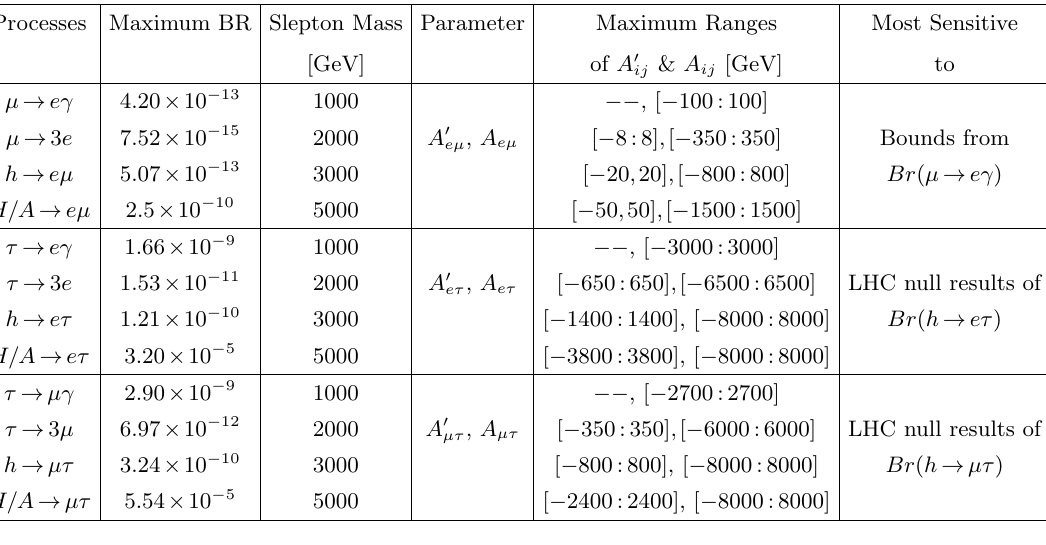
Table 4. Allowed ranges of holomorphic and non-holomorphic trilinear couplings and the corre- sponding maximum decay branching ratios after avoiding charge breaking minima, respecting the upper limits of various other LFV decays and LHC constraints on the o(cid:11)-diagonal Yukawa